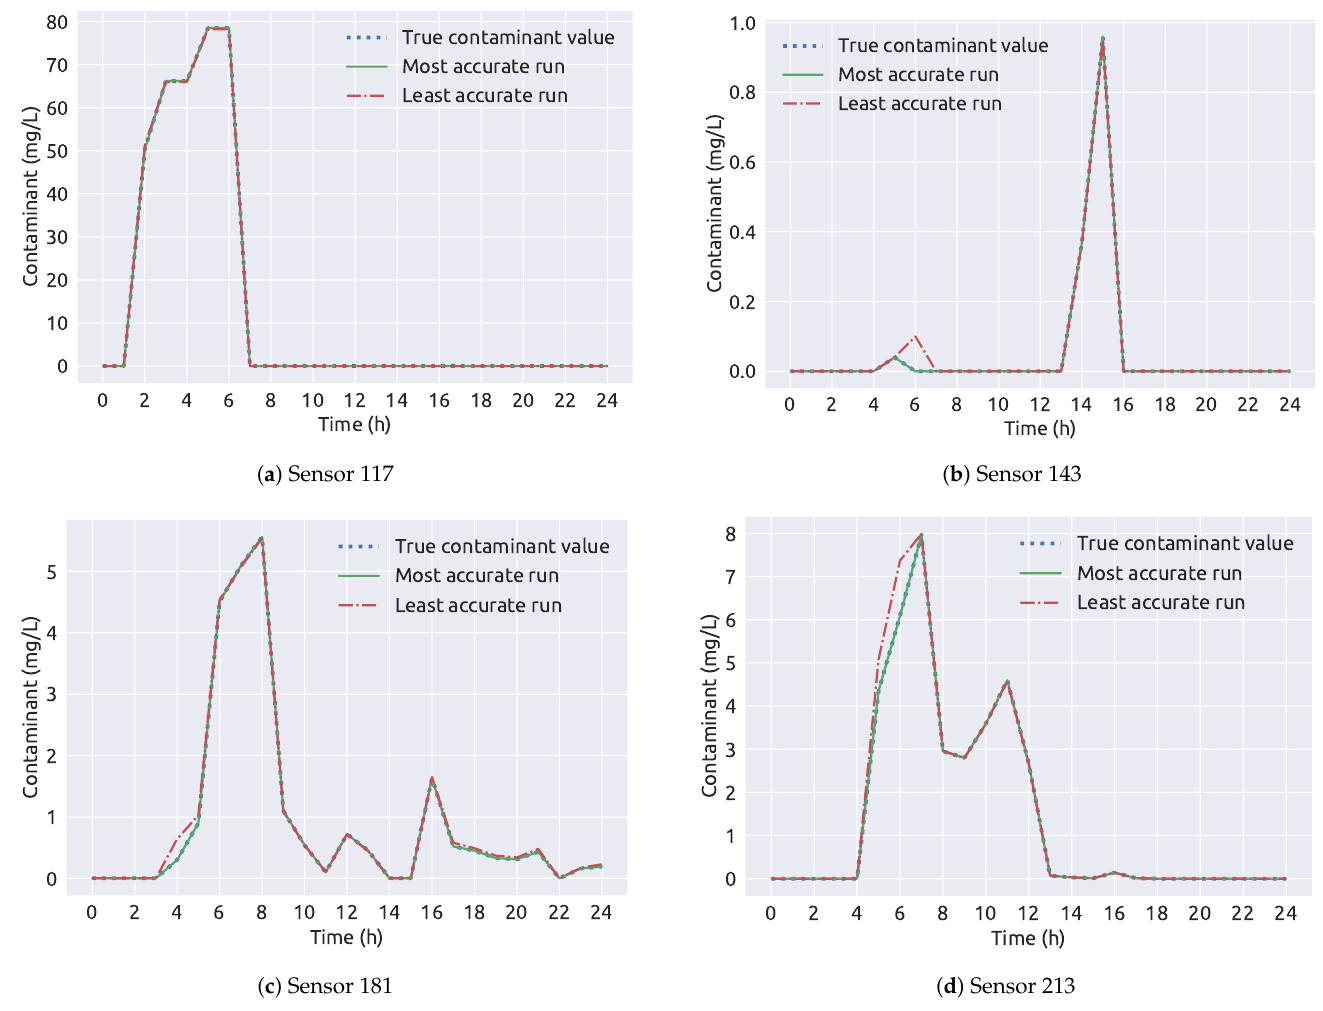
Figure 12. A comparison of sensor measurements through time for the NET3 benchmark network (framework 2). Table 10. Richmond RF regression average values and standard deviations for 100 runs with an absolute error.